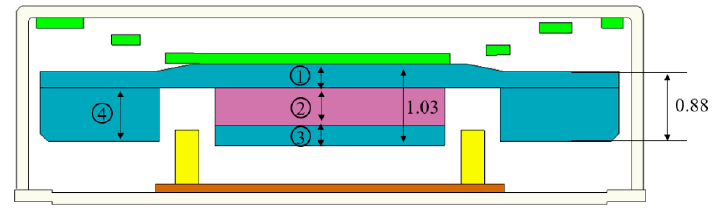
Figure 25. Thicknesses of the magnetic circuit components.